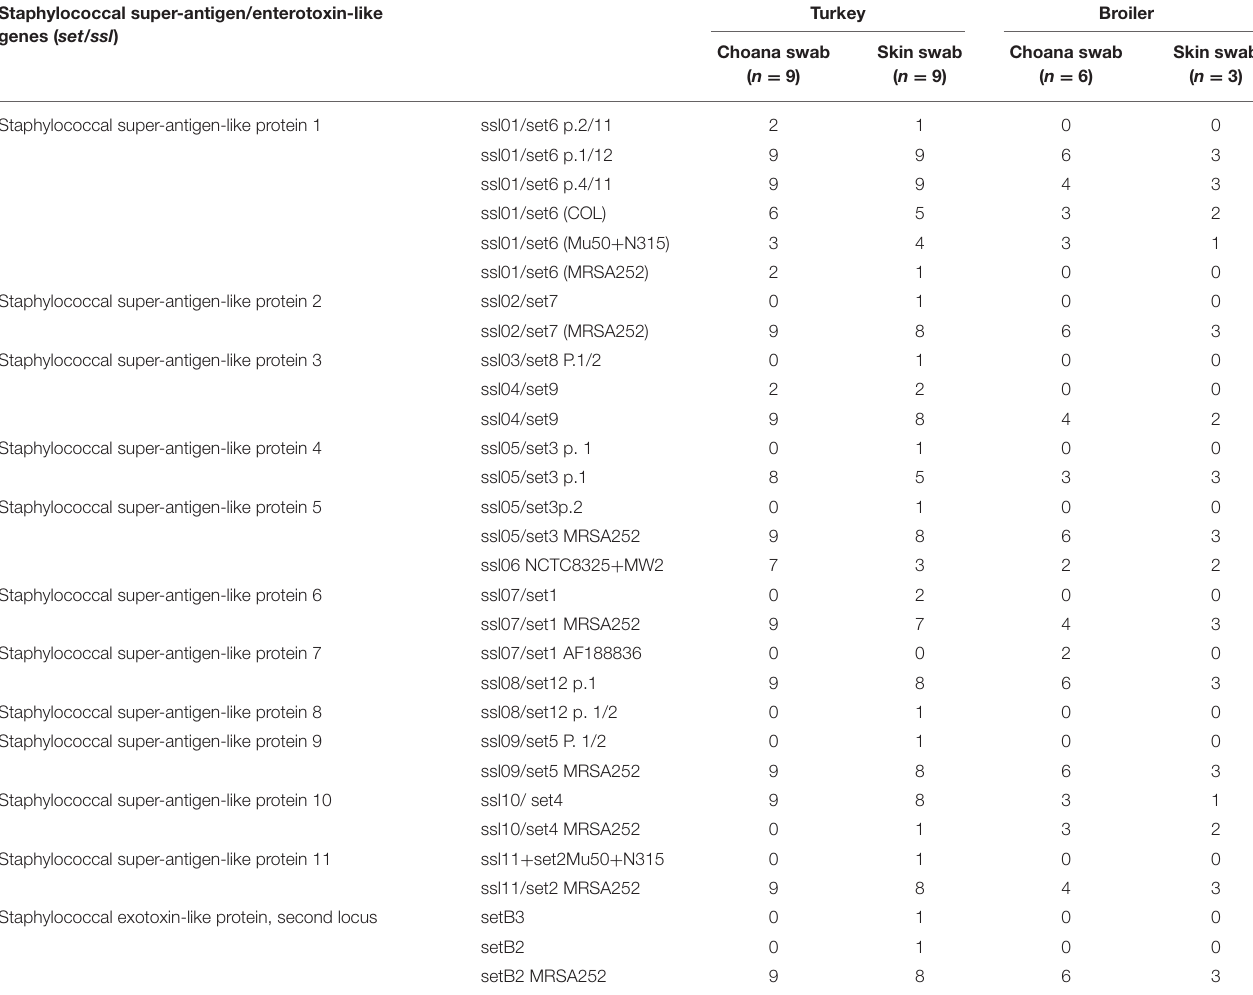
Turkey Broiler Choana swab Skin swab Choana swab Skin swab ( n = 9) ( n = 9) ( n = 6) ( n = 3)